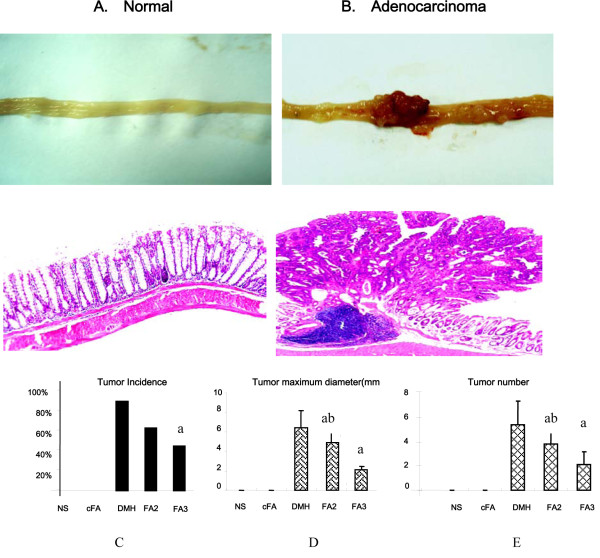
Main results of the animal experiment after sacrificed at the 24 weeks. A. The morphology of normal colon in macroscopic observation (Upper) and microscopy (HE stained) (Lower). Neither signs of injury nor tumor were found in NS group and cFA group. B. The morphology of colon adenocacinoma in macroscopic observation (Upper) and microscopy (HE stained) (Lower). C. The incidences of DMH-induced colorectal tumor in different groups. DMH group is 90%, which is much higher than any other groups such as FA2, FA3 which are 63%, 45% respectively. Meanwhile, there is none in NS and cFA group. D. Maximum diameter of tumor among the 5 groups (NS, cFA, DMH, FA1 and FA2). E. Tumor number in mice among the above 5 groups. (a: P < 0.05, FA3 and FA2 compared to DMH group; b: P < 0.05, FA2 compared to FA3 group)